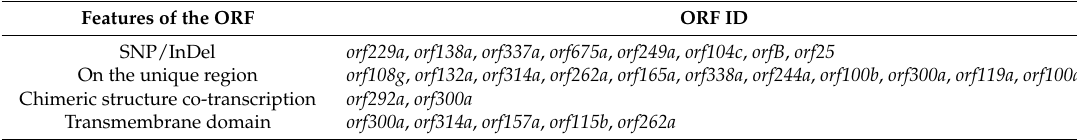
Table 1. Features of the candidate genes controlling the